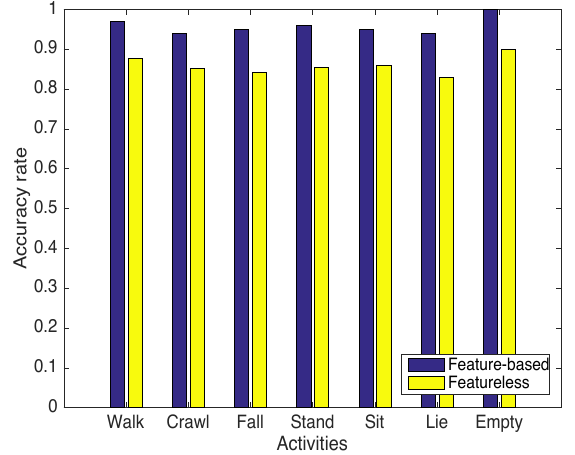
Figure 10. SRC-classification accuracy with feature extraction and with featureless